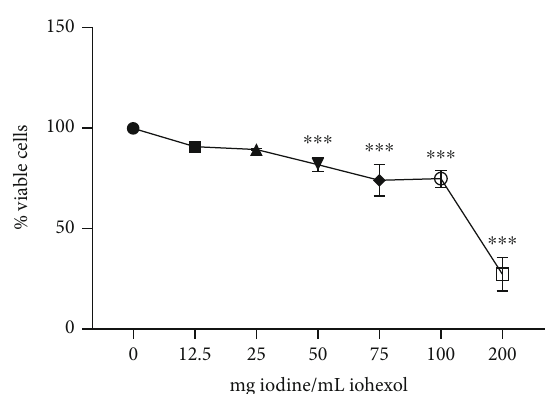
Figure 1: MTT 3-(4,5-dimethyl (thiazol-2-yl)-2,5-diphenyl tetrazolium bromide) assay to quantify cell viability in Vero cells exposed to graded concentrations of iohexol. One-way ANOVA and Tukey posttest ( n = 4 ) were used to analyse the results. ∗ p < 0 : 05 , ∗∗ p < 0 : 01 , and ∗∗∗ p < 0 : 001 (2-tailed) in comparison with the